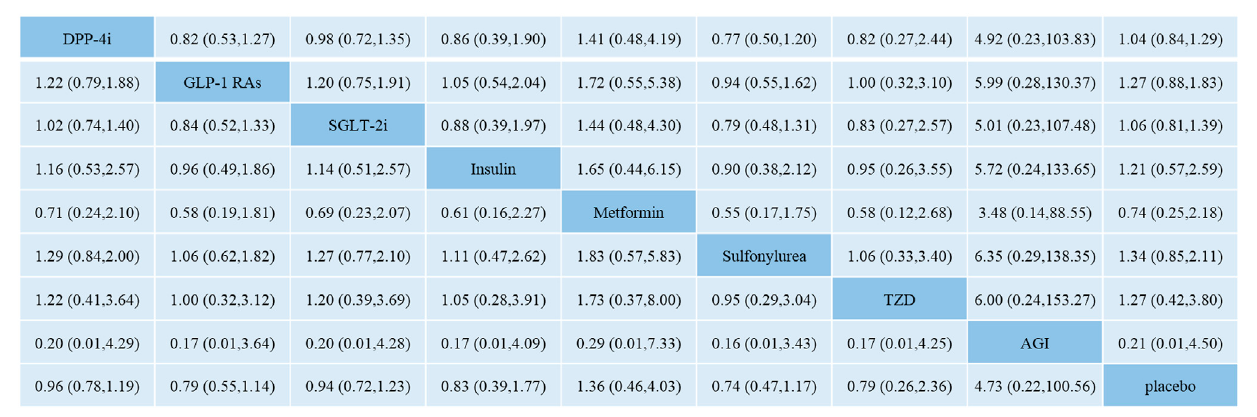
FIGURE 3 | Odds ratio with 95% CI of network meta-analysis for risk of fracture. Note: Results of direct comparisons were listed in the upper triangle, and the estimationwascalculatedastherow-de fi ningtreatmentcomparedwiththecolumn-de fi ningtreatment.Resultsofnetworkmeta-analysiswerelistedinthelowertriangle, and the estimation was calculated as the column-de fi ning treatment compared with the row-de fi ning treatment. NA: not available. DPP-4i: dipeptidyl peptidase-4 inhibitors; GLP-1 RAs: glucagon-like peptide-1 receptor agonists; SGLT-2i: sodium-glucose cotransporter-2 inhibitors; TZD: thiazolidinedione; AGI: alpha- glucosidase